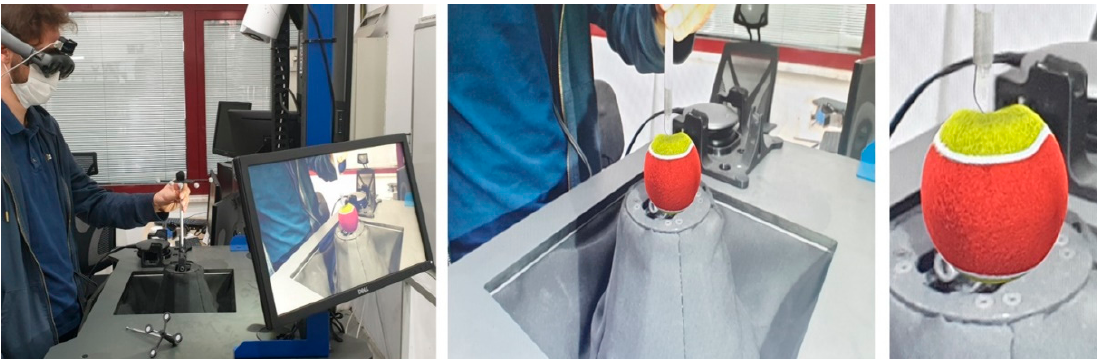
Figure 12. Real and mixed reality views of the synchronization experiment.